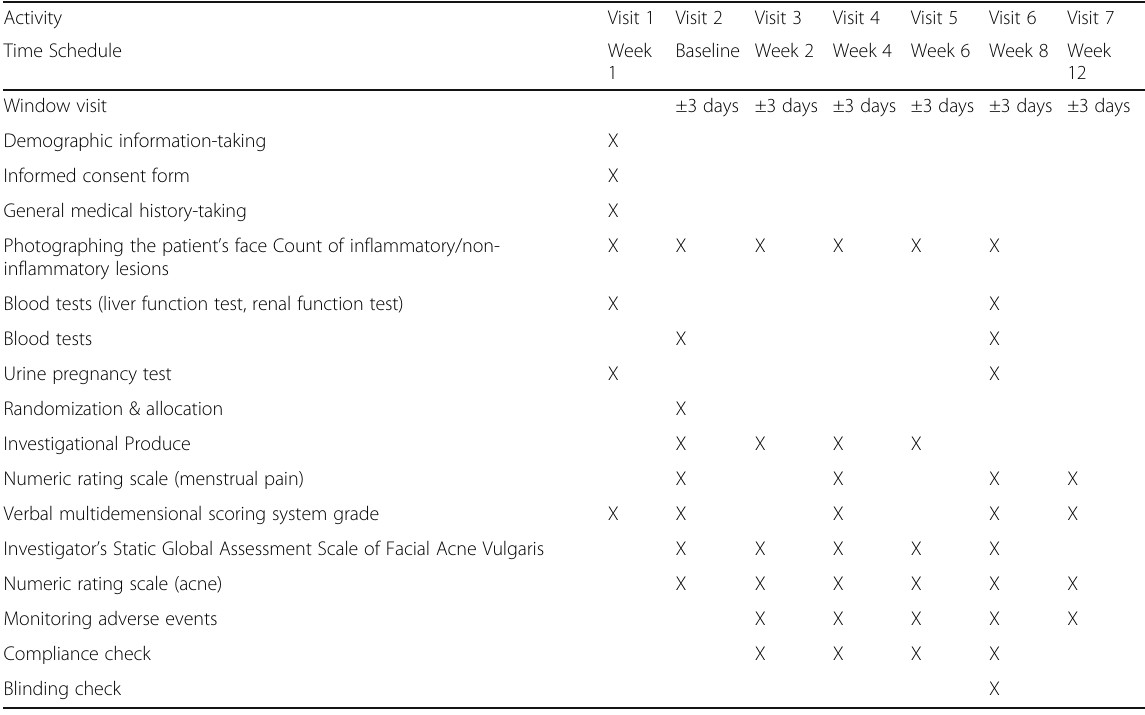
Table 1 Study process treatment and outcome measurements Activity